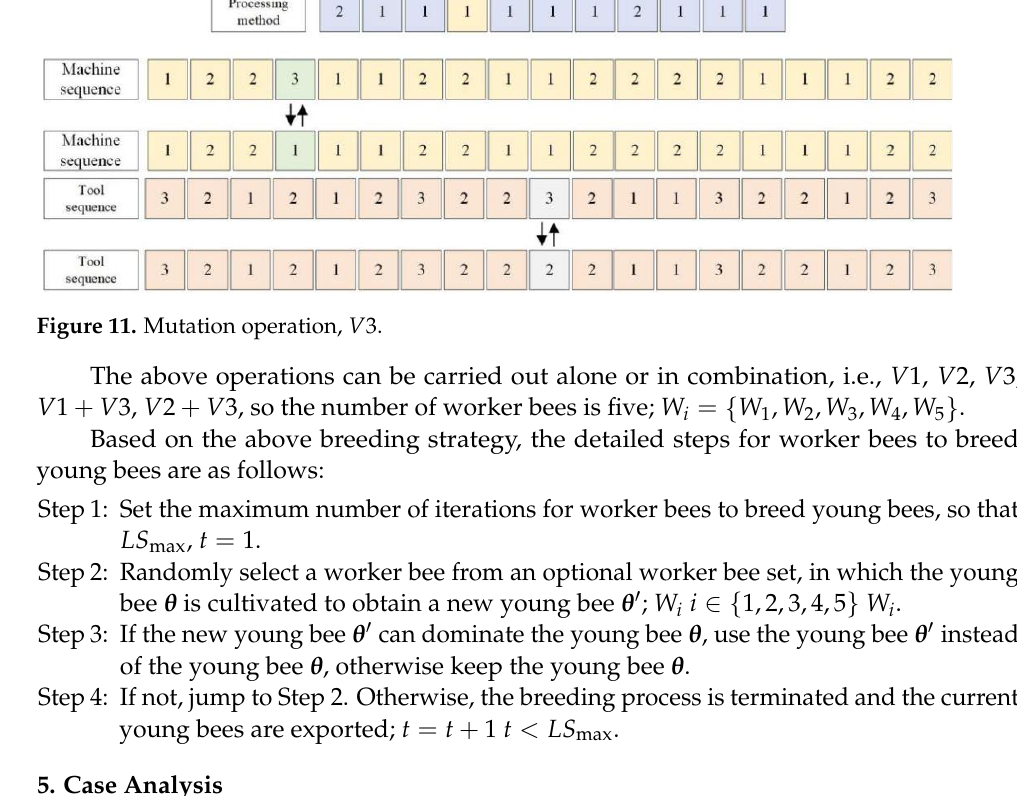
Figure 11. Mutation operation, 3 V .